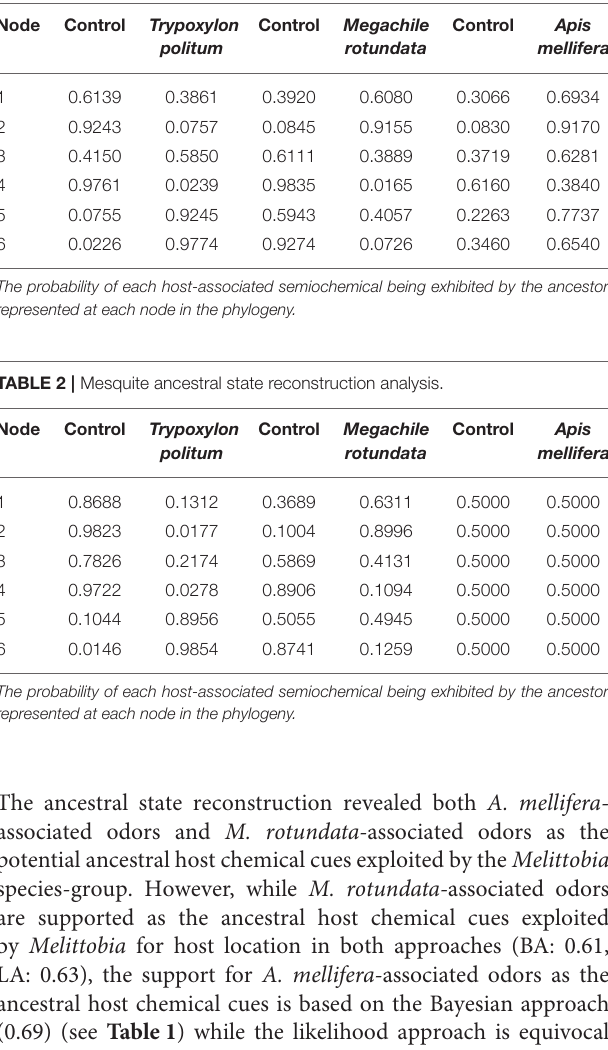
TABLE 1 | SIMMAP ancestral state reconstruction